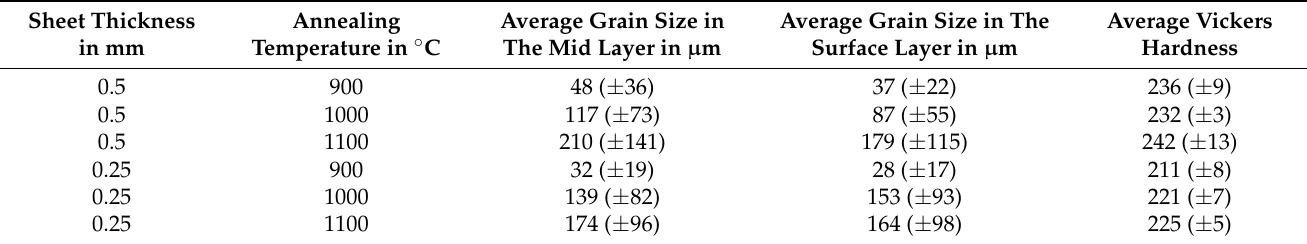
Table 2. Overview of produced electrical steel sheets. Values in brackets represent the standard deviation. Sheet Thickness in